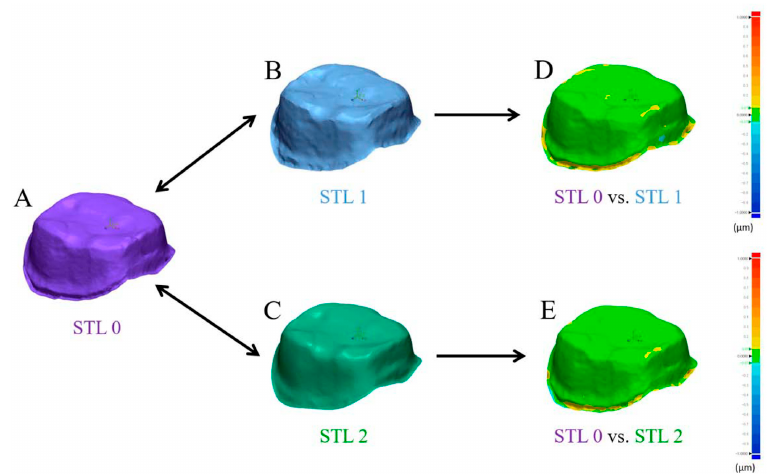
Figure 7. Simplified graphic representation of the analysis by best-fit alignment, A, Scan data of the gypsum model by laboratory scanner, B, Scan data using the AEGIS intraoral scanner, C, Scan data using the CEREC intraoral scanner, D, Deviation after superimposition of A and B displayed in a color-coded map. E, Deviation after superimposition of A and C displayed in a color-coded map.